Question: Provide a publication-style caption for this figure.
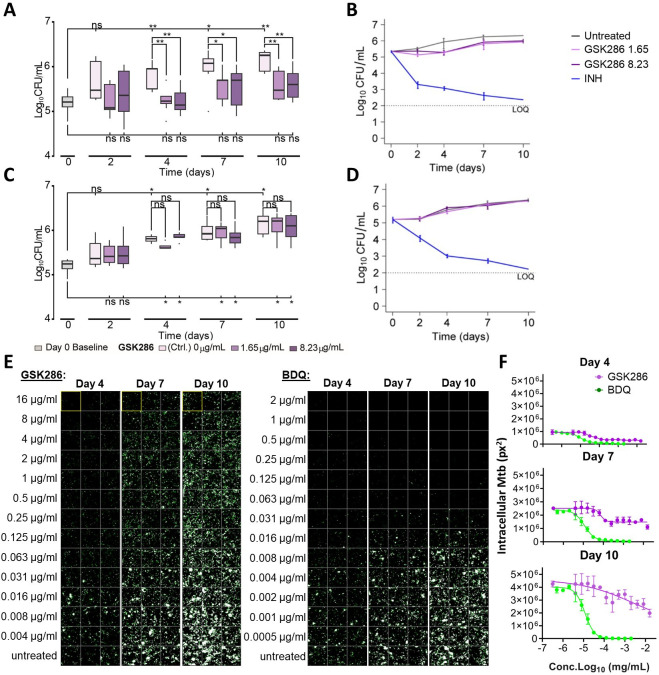
Answer: Intracellular activity of GSK286 against Mtb. The activity of GSK286 at 1.65 µg/mL and 8.23 µg/mL against the Mtb Erdman wild-type ( A and B ) and Mtb EM19 (resistant Rv1625c mutant) ( C and D ) strains was measured intracellularly in infected macrophages derived from human CD14 + monocytes over a period of 10 days. Two-way ANOVA and post hoc Wilcoxon test (non-parametric) with Benjamini-Hochberg correction were performed for statistical analyses. ns, not significant, * = P < 0.05; ** = P < 0.01. ( E ) Confocal microscopy images at days 4, 7, and 10 post-treatment of intracellular Mtb H37Rv-GFP infecting THP-1 macrophages and treated with increasing concentrations of GSK286. BDQ is used as a positive control. ( F ) Quantification of the bacterial burden based on pixel intensity (px²) relative to log 10 drug concentration at days 4, 7, and 10 post-treatment.